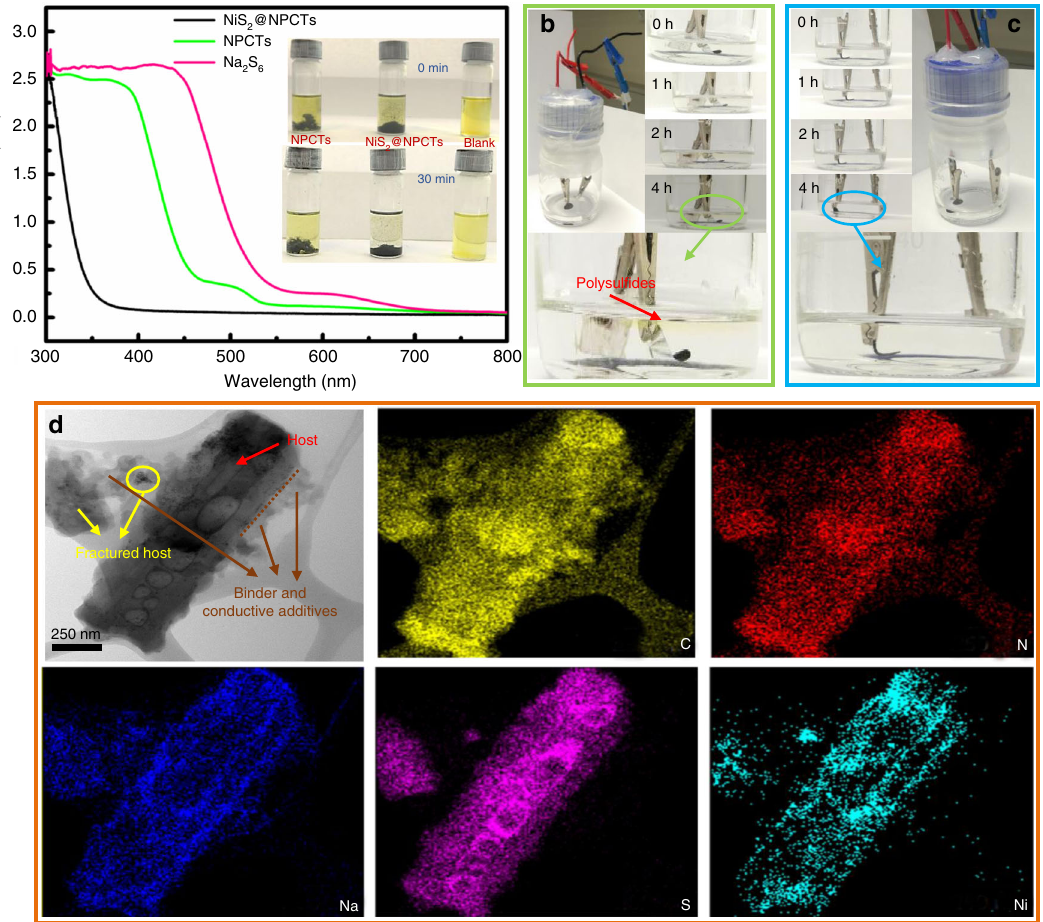
Fig. 3 Visible adsorbability to polysul fi des. a Ultraviolet/visible (UV – vis) spectra and corresponding photographs (inset) of pure Na 2 S 6 solution and the solution after exposure to NiS 2 @NPCTs and NPCTs. Visual con fi rmation of polysul fi de entrapment of b NPCTs/S and c NiS 2 @NPCTs/S at speci fi c discharge depths. d STEM-EDS mapping images of NiS 2 @NPCTs/S composite after 100